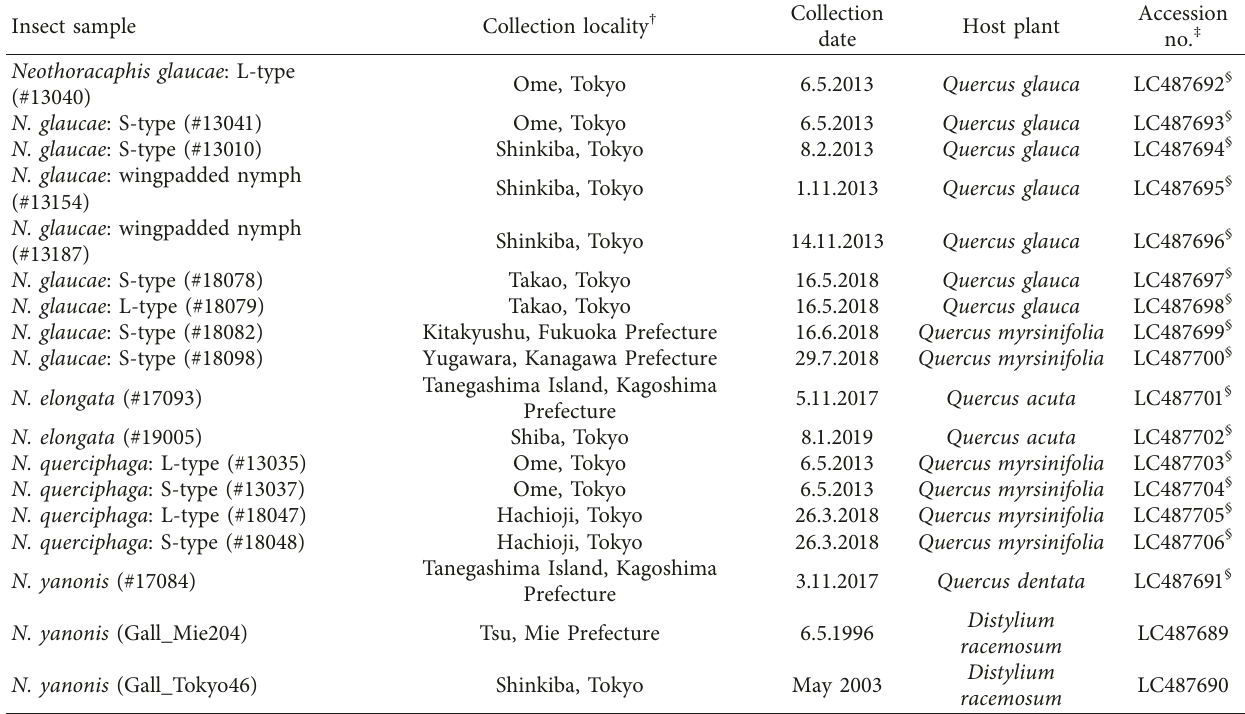
Table 2: Aphid samples subjected to DNA sequencing.